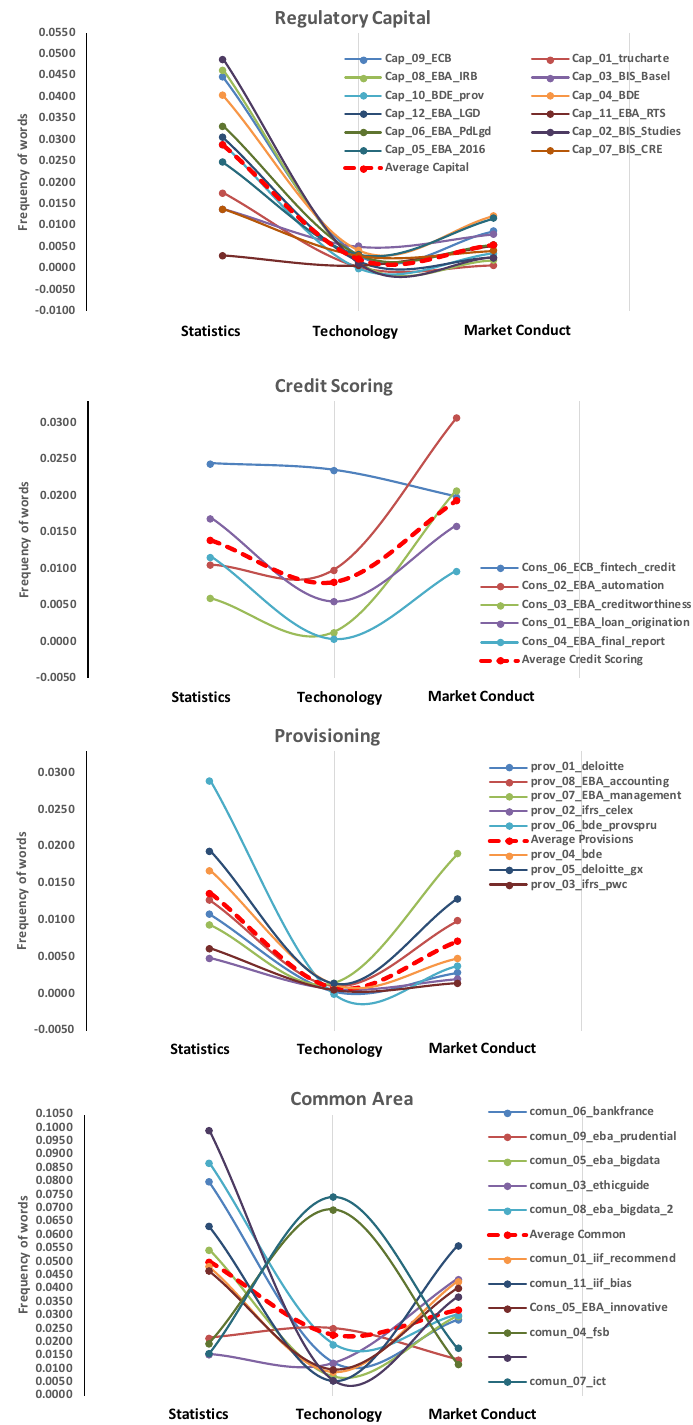
Fig. 9 Calculation of regulatory requirements using NLP, for each model